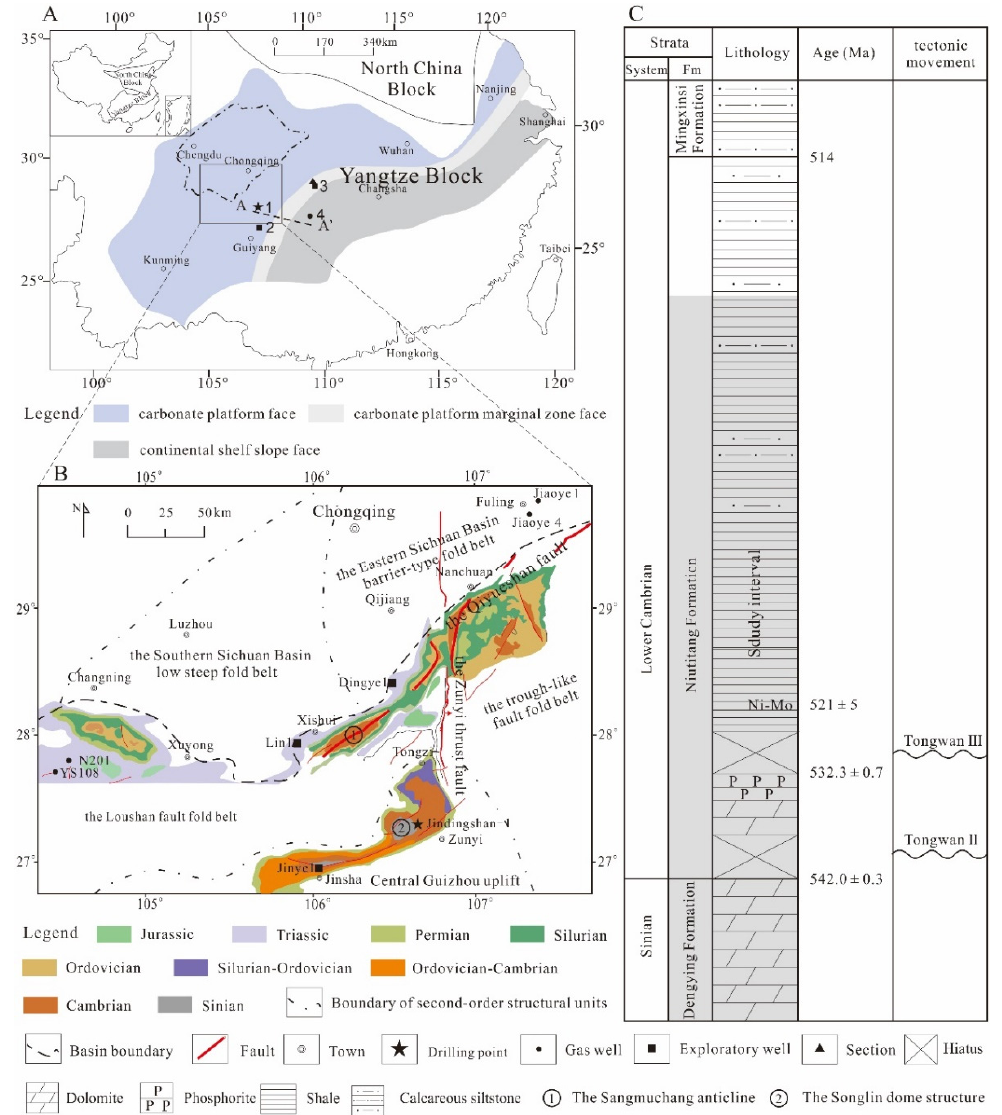
Figure 1. ( A ) Simplified paleogeographic map of the Yangtze Block around the Sinian-Cambrian boundary interval (modification of the map presented by [14]). The location of JDS-1 well is marked by stars. The lower Cambrian Niutitang Formation black shales were deposited in the carbonate platform. ( B ) Regional, geological, and tectonic profiles of the study area, showing JDS-1 well and exposed strata. ( C ) Stratigraphic column and studied intervals. Sections: 1—Jindingshan; 2—Kaiyang; 3—Youyang; and 4—Cen’gong. Fm = Formation.